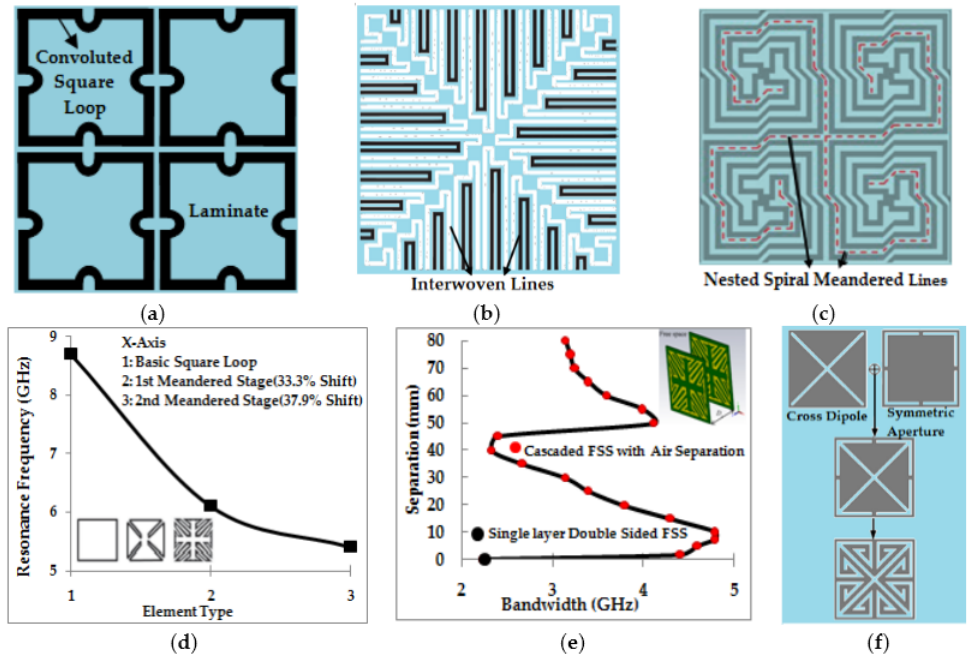
Figure 6. ( a ). Convoluted square loop FSS ( b ). Array element with interwoven geometry ( c ) The geometry of the miniaturized element based on meandered lines showing 2 × 2 unit cells [64] ( d ) FSS based on meandered elements showing the variation of resonant frequency with the inclusion of meandered stage [65]. ( e ) Bandwidth versus air separation of cascaded FSS [65] ( f ) Evolution process of the FSS unit cell in